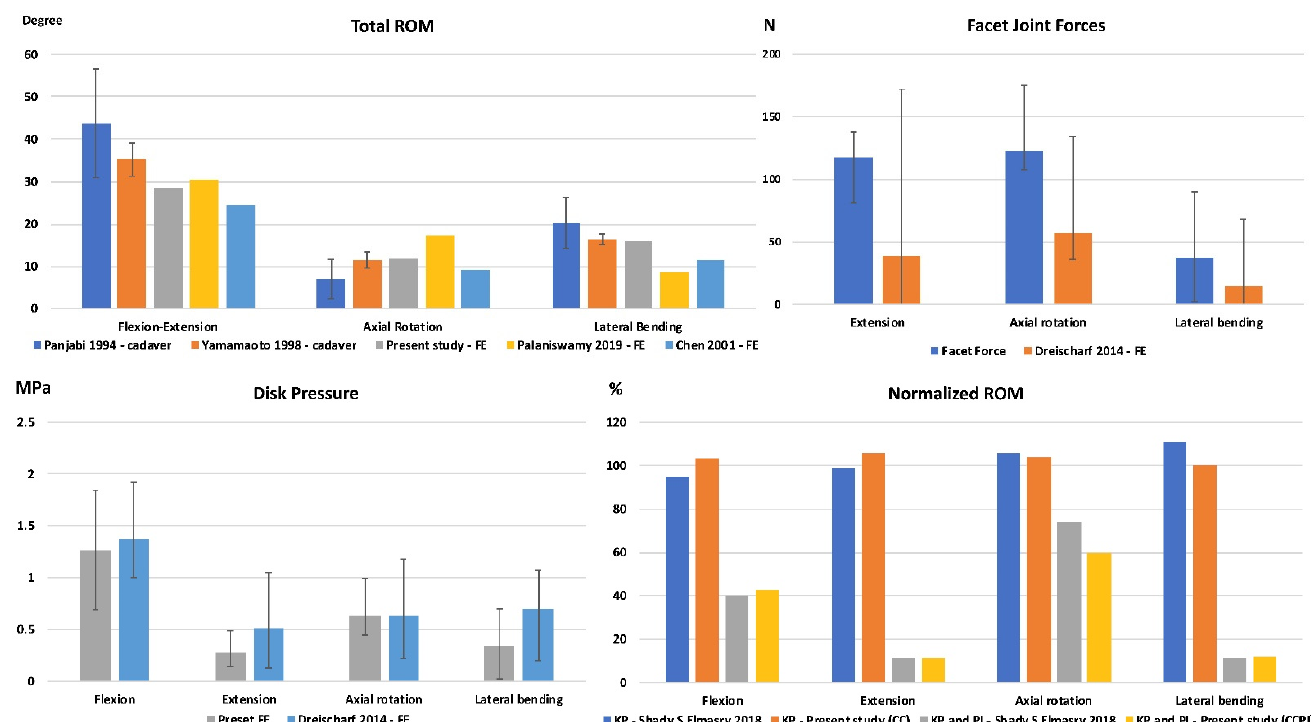
Figure 4. The results of validation of total ROMs, facet joint force and peak disk stress (median, maximum, and minimum of the four disks), and normalized ROM with bone cement and SpineJack .